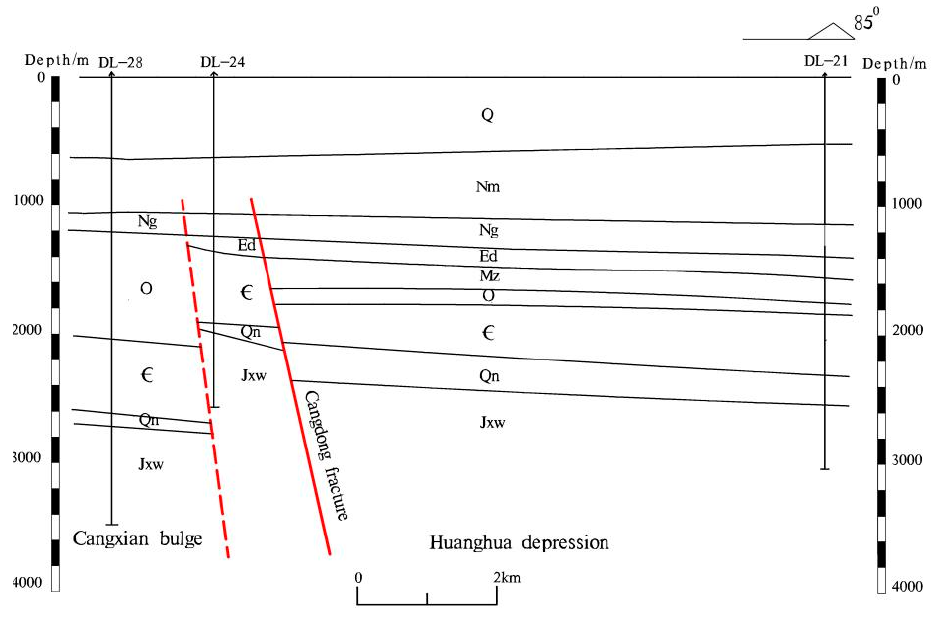
Figure 2. Geological section of Cangdong